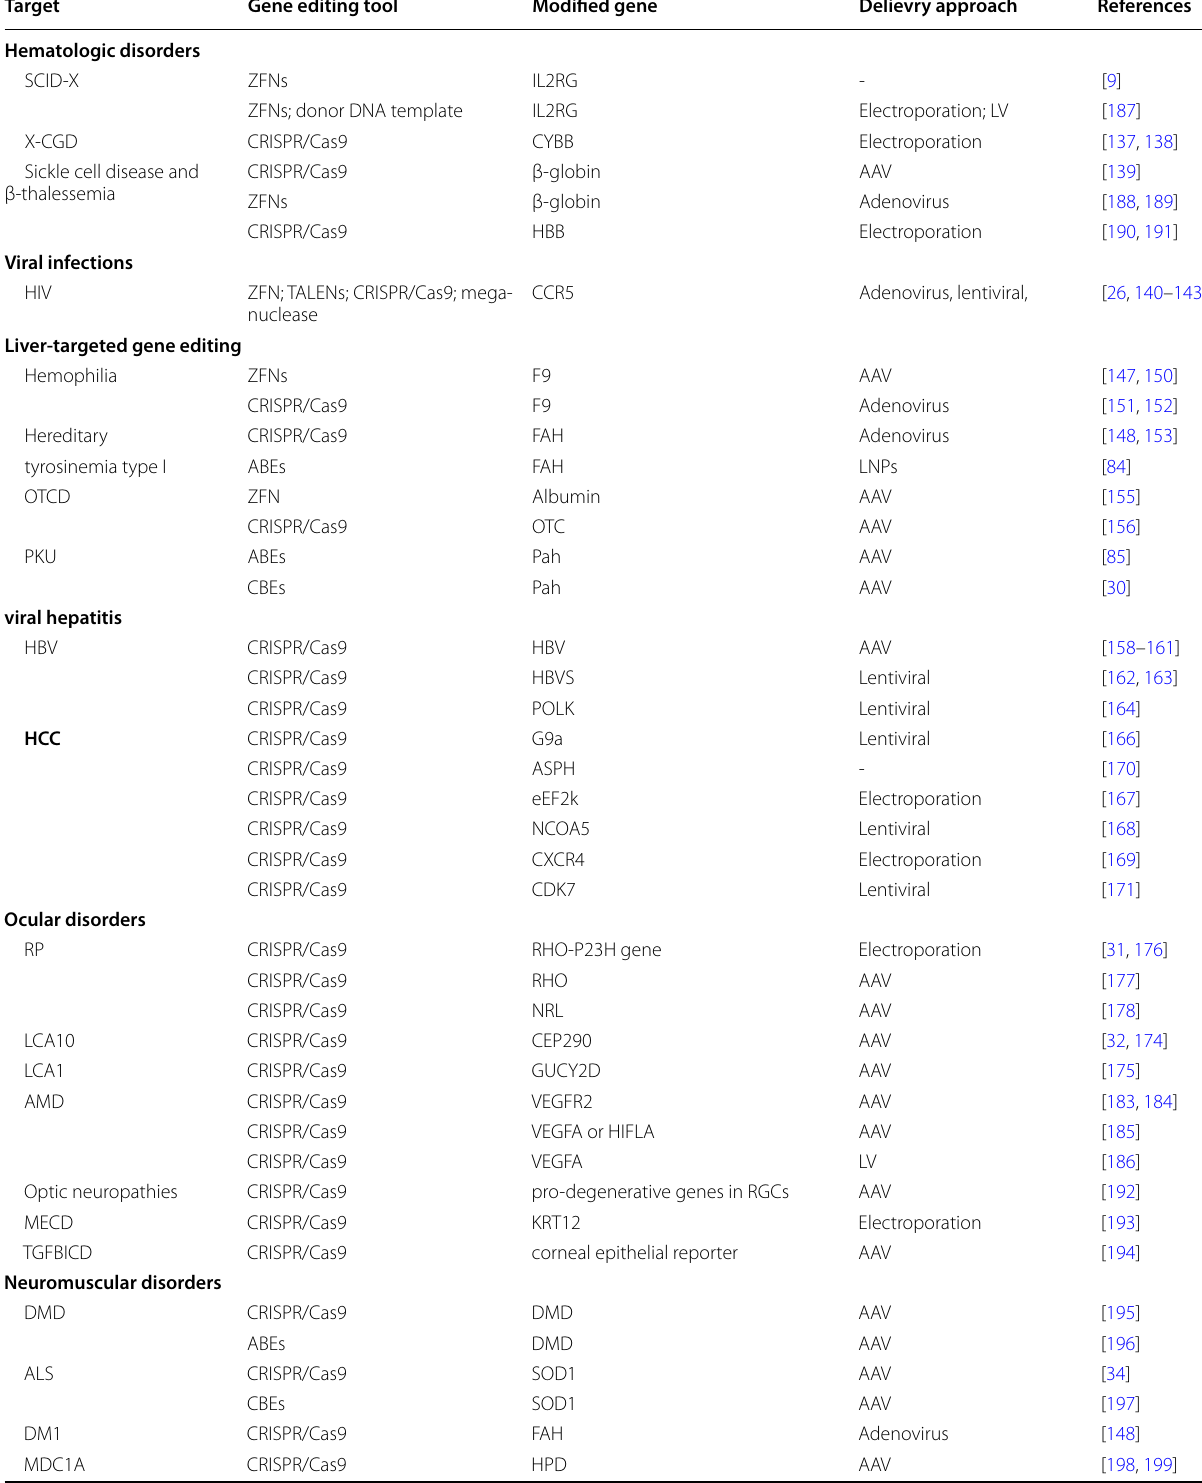
Table 3 Representative preclinical studies of therapeutic gene editing